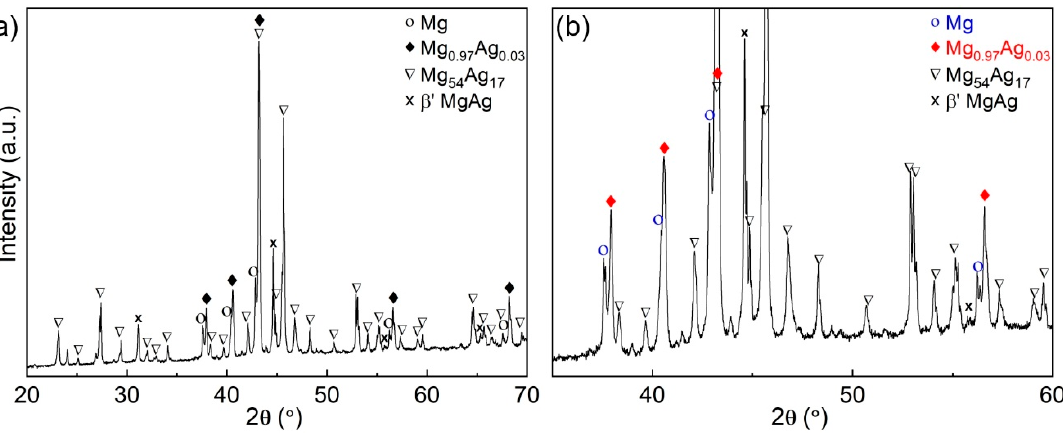
Figure 1. X-ray diffraction pattern of a Mg 67 Ag 33 specimen solidified at high cooling rates by suction casting. The microstructure is composed of the Mg, Mg 0.97 Ag 0.03 , β ′ MgAg and Mg 54 Ag 17 phases and their reflections are indicated. ( a ) Overview over whole measured 2 θ -range and ( b ) the magnified section highlights both hcp Mg phases.